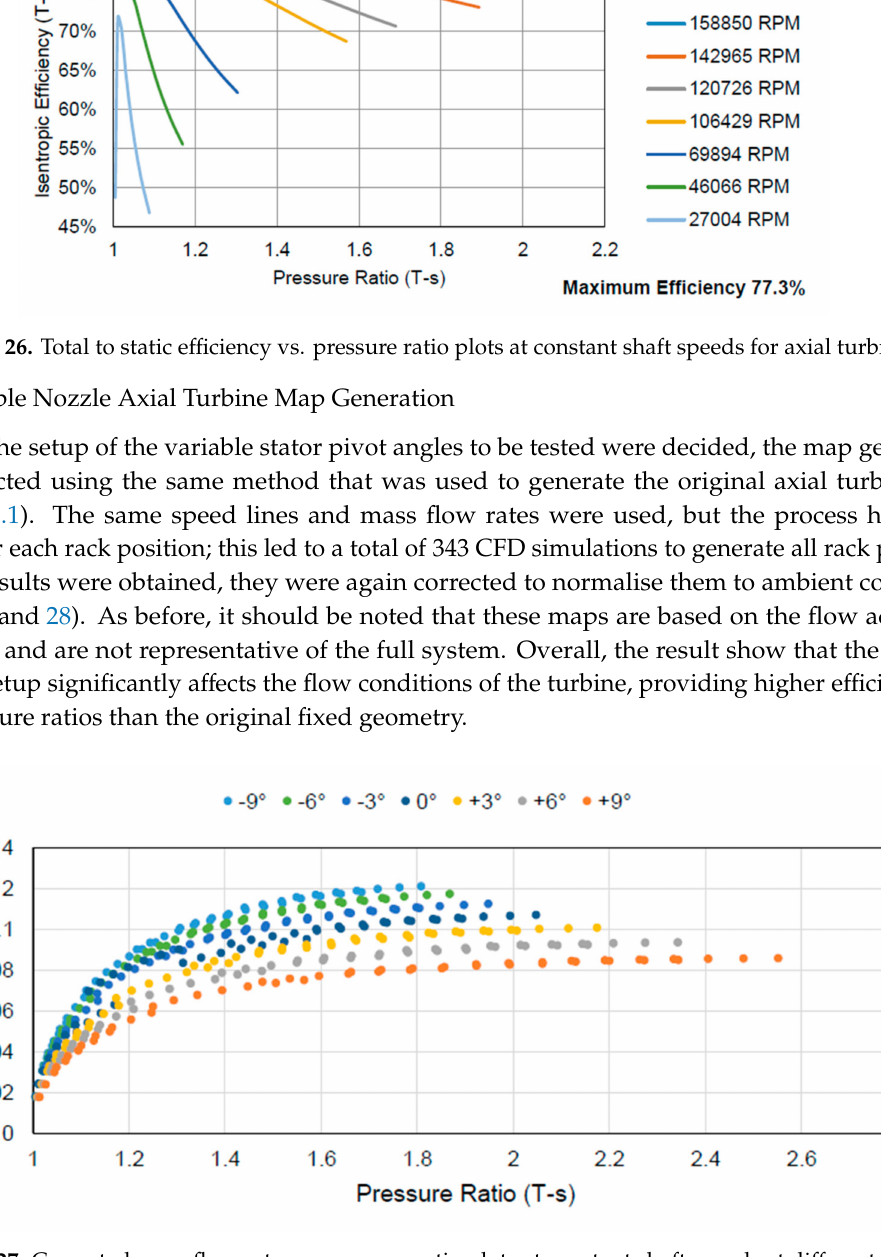
Figure 27. Corrected mass flow rate vs. pressure ratio plots at constant shaft speeds at di ff erent rack positions for VNT (Variable Nozzle